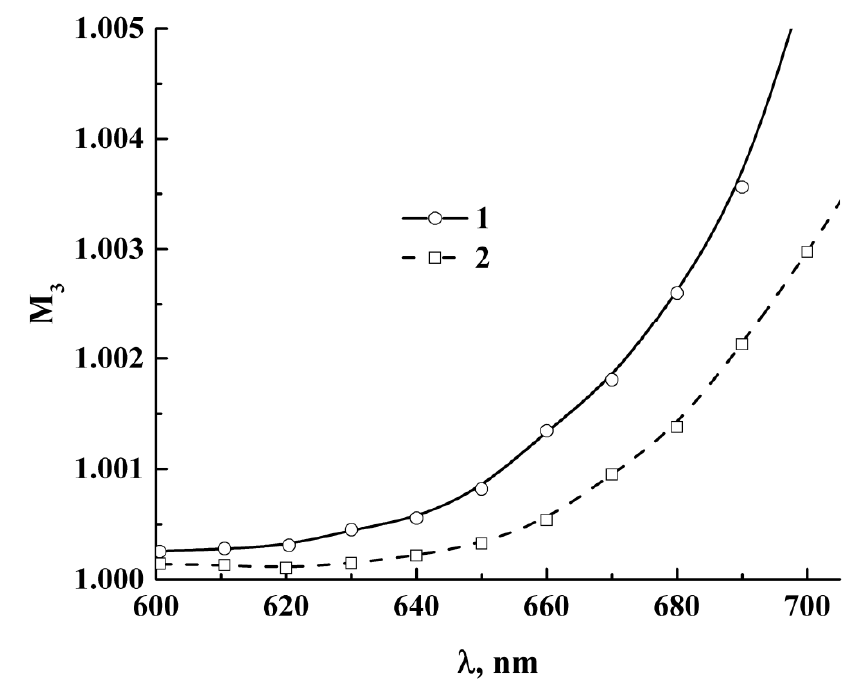
Figure 10. The noise-corrected wavelength-dependent values of the normalized third-order moment of intensity fluctuations in the spectral region of interest for TiO 2 -based (1) and SiO 2 -based (2) systems.